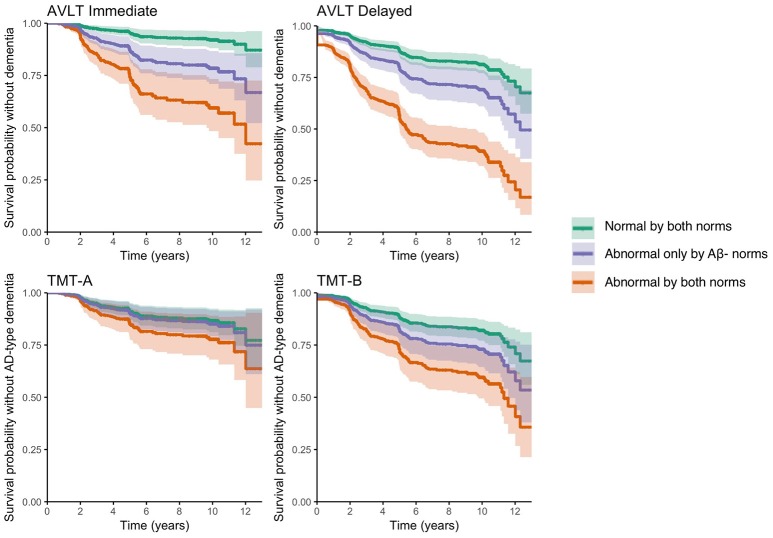
Progression to dementia for groups classified by current and Aβ- normative data in validation dataset. Survival probability without dementia for individuals who perform normal according to both norms (group 1), individuals who perform abnormal only according to Aβ- norms (group 2), individuals who perform abnormal according to both norms (group 3) on the AVLT Immediate (top left), AVLT Delayed (top right), TMT-A (bottom left), and TMT-B (bottom right). Survival curves are adjusted for age, gender, and education.